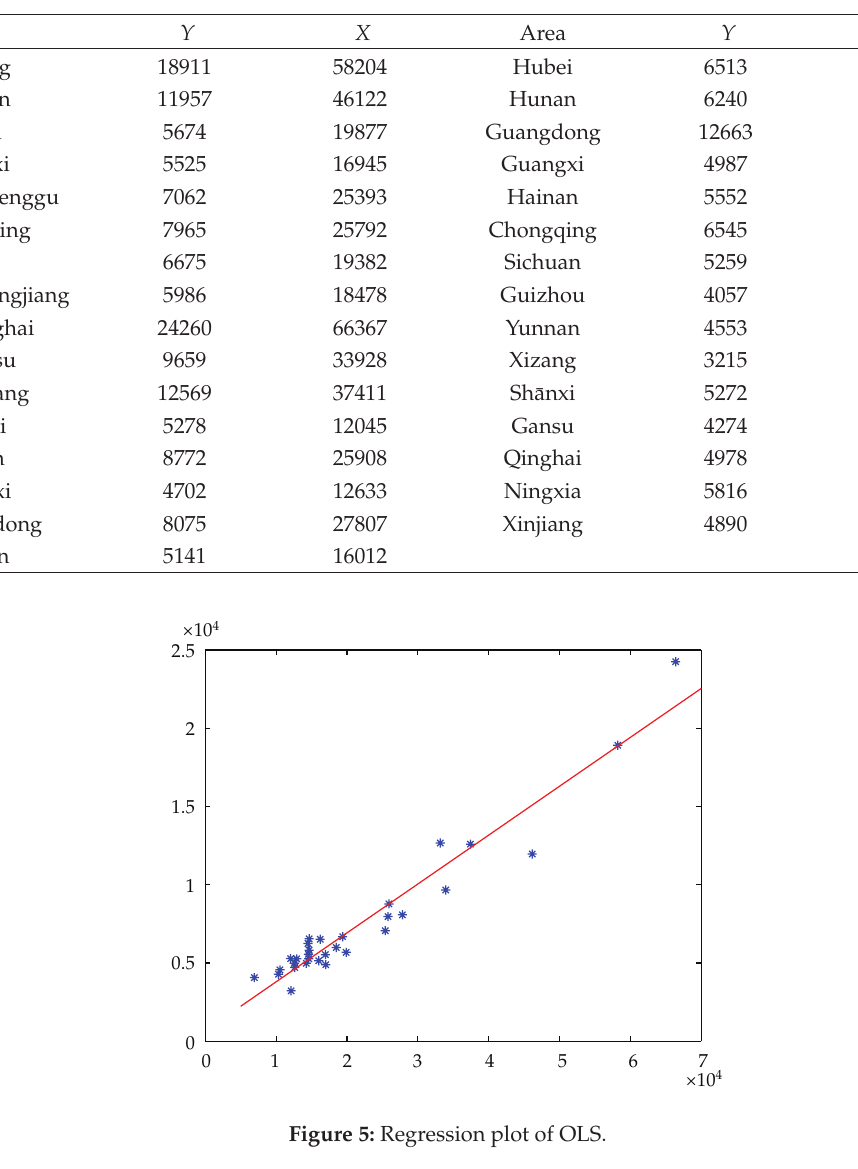
Table 3: Per capita consumption and per capita GDP for all provinces or cities in the People’s Republic of China, 2008 (cid:6) values are in yuan of RMB (cid:7) .